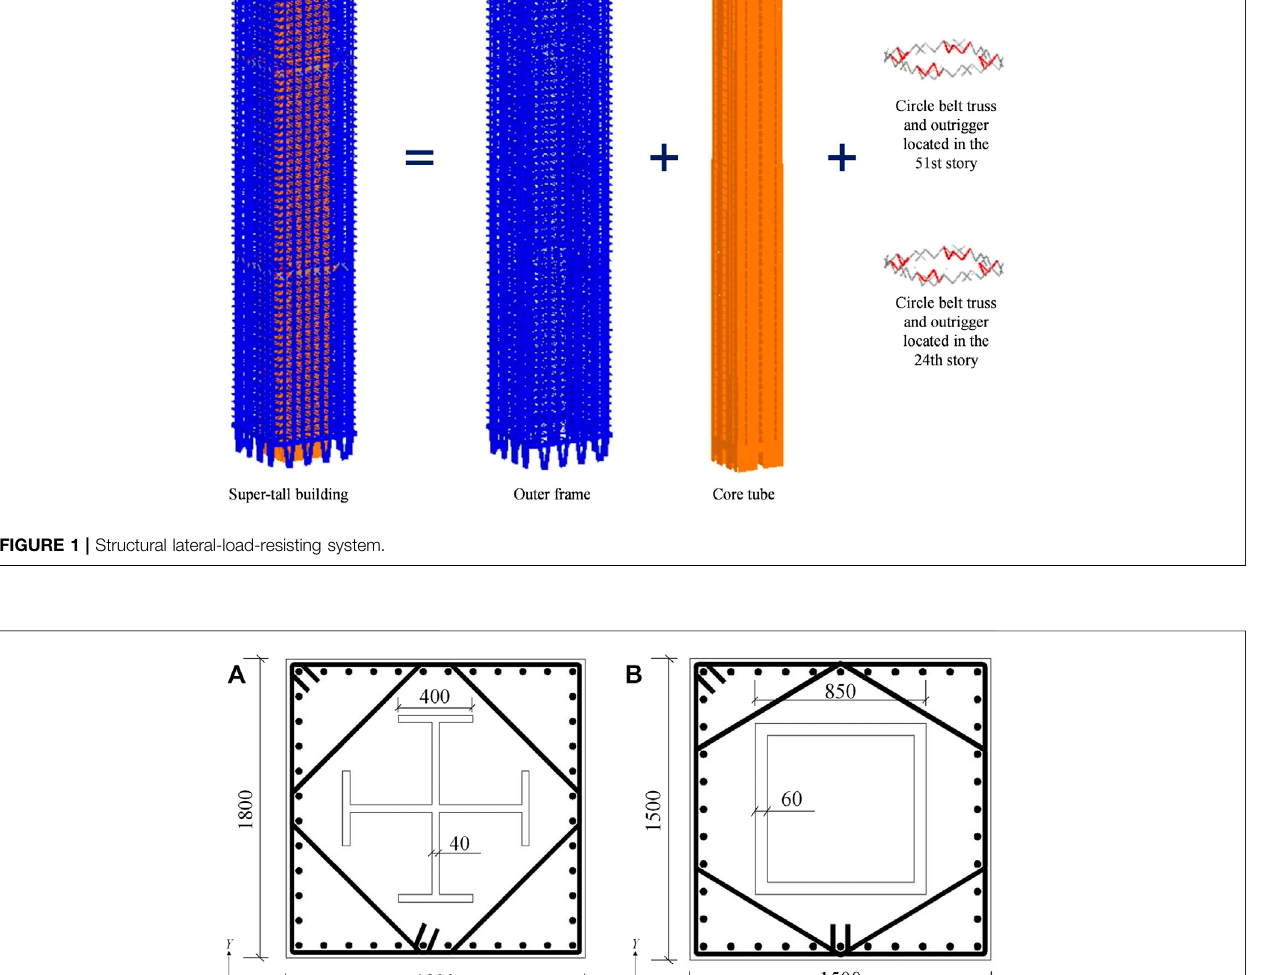
The outer frame of the structure comprises cross- and box- shaped steel-reinforced concrete (SRC) columns and I-shaped steel beams. Typical sections of the SRC columns are presented in Figure 2 . Based on the requirements of the building function, 16 groups of V-shaped SRC columns with a square section measuring 1.8 × 1.8 m are adopted to realize the fi rst story with a height of 15.3 m. SRC shear walls and reinforced concrete (RC) shear walls are adopted for the core tube. The thickness of the shear walls decreases gradually with the height of the building. The thickness of the SRC shear walls in the bottom strengthening region ( fi rst to ninth stories) is 1.4 m. The yield